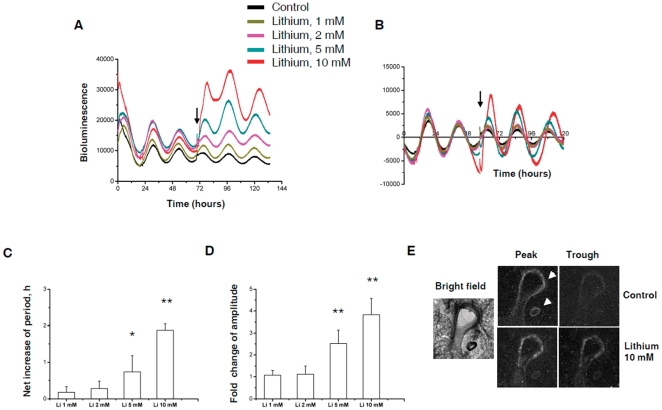
Lithium lengthens circadian period and enhances PER2::LUC expression in lung slices.A,B, Representative PER2::LUC traces from ectopic lung slices (A, raw data; B, baseline correction of raw data). Black arrow indicates time of lithium treatment. Untreated group was used as control. C,D, Period and amplitude analysis. The net period changes were analyzed by normalizing to the control slices and expressed as mean ± SEM. The amplitude changes were analyzed based on the first peak after treatment in the baseline corrected data. *, p<0.05; **, p<0.01, n = 5. E, Bright field and bioluminescence imaging of lung slices. Peak and trough of oscillations were determined based on the bioluminescent intensity of the CCD camera recording. White arrowheads indicate bronchiole and blood vessel.